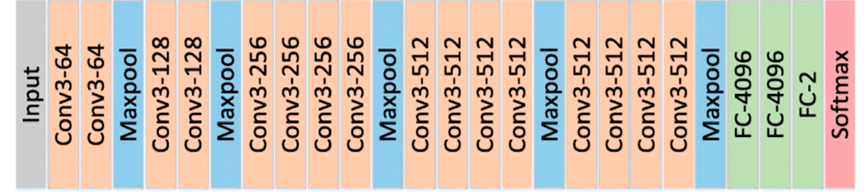
Figure 6. The main architecture of VGG-19 network.